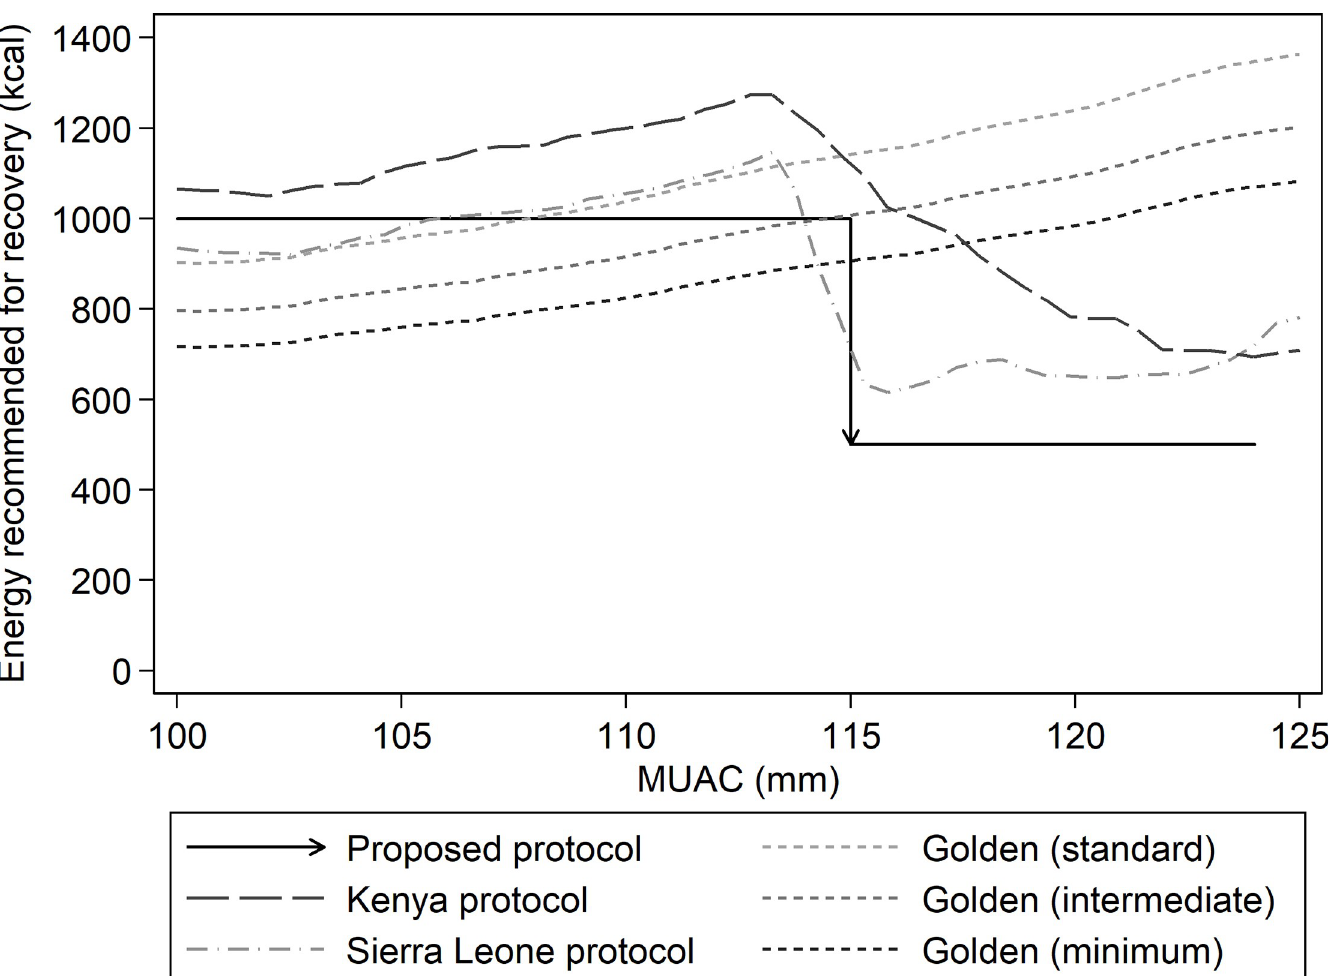
Fig 4. Comparison of mean energy provided by each of five protocols: The protocol proposed herein, Golden’s minimum, intermediate, and standard protocols, the Sierra Leone protocol, and the Kenya protocol.